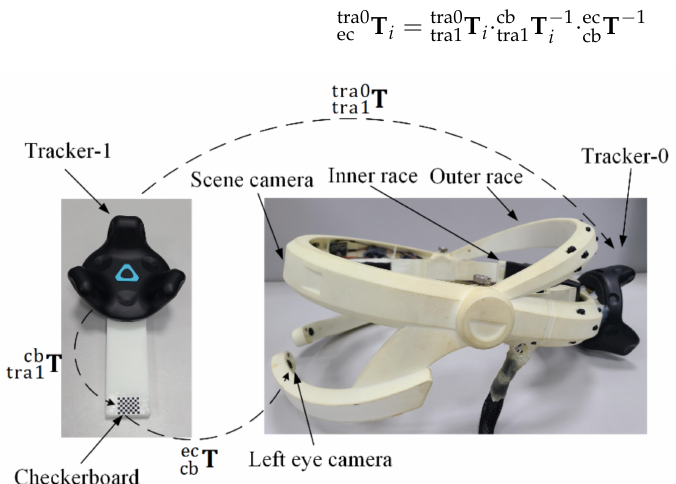
Figure 2. Illustration of estimation method for the cameras’ coordinate system. The left eye camera is taken for